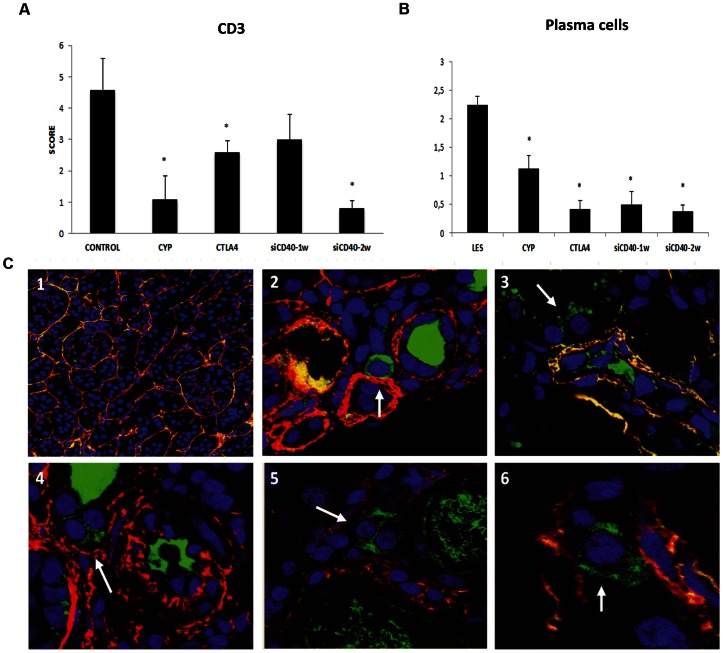
Kidney cell infiltrate characterization and plasma cell localization.A) CD3 presence was semi quantitatively graded B) Plasma cells were semi quantitatively graded and localized in the tubule-interstitium of renal cortex. C) 1.Representative photomicrograph (x400) of siCD40-2 group. Note the absence of plasma cells. 2–6. Photomicrographs (x630) of plasma cell localization in untreated group (arrows). Data are expressed as mean±SEM. *p<0.05 vs untreated.